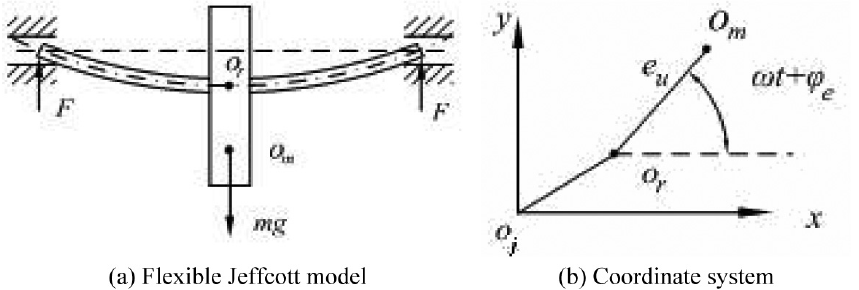
Fig. 1. Computer model and coordinate